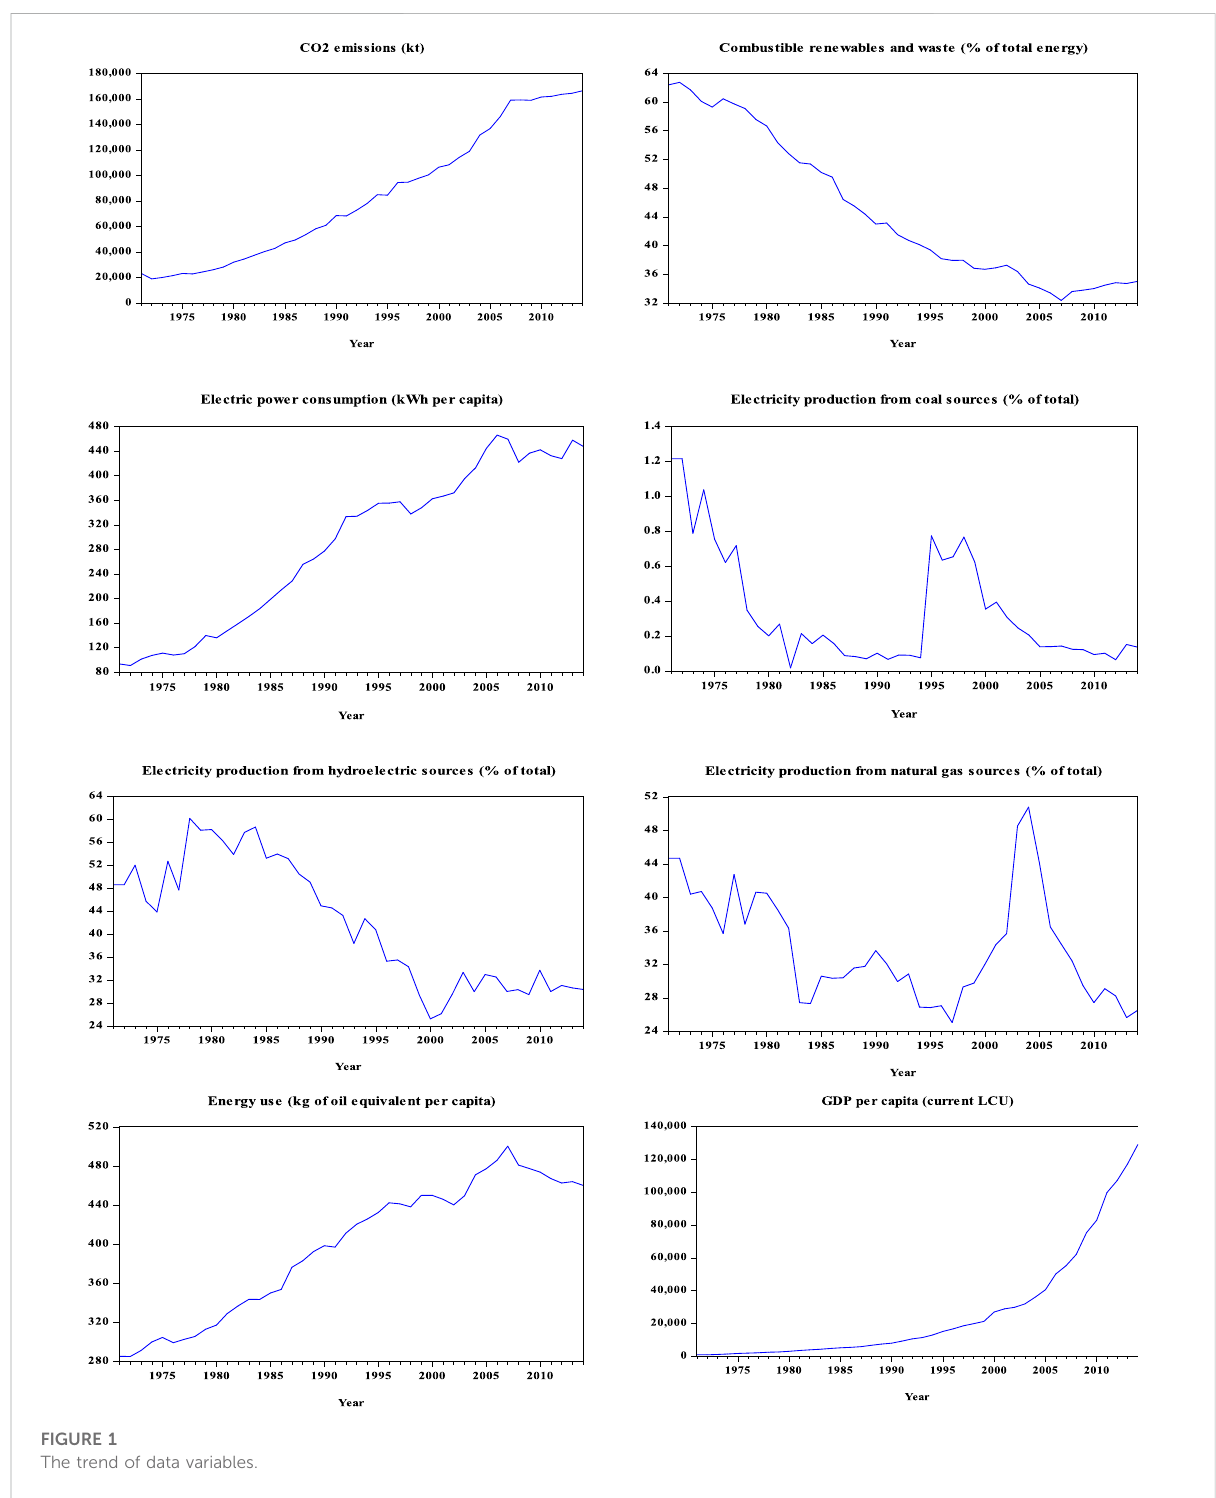
FIGURE 1 The trend of data